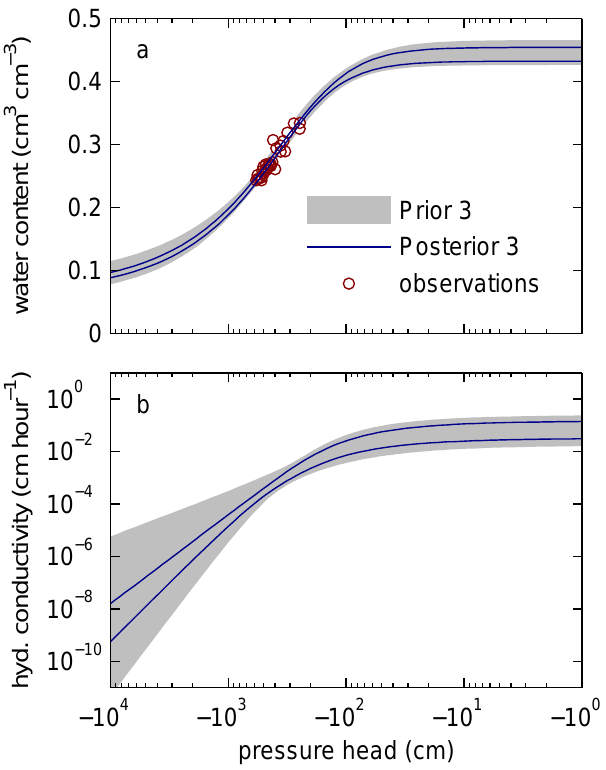
Fig. 10. Diagnostic plots of the model residuals using real soil wa- ter content data: (a) autocorrelation function with theoretical 95% significance intervals of a time series of uncorrelated residuals, (b) residuals as a function of the predicted soil water content, and (c) quantile-quantile